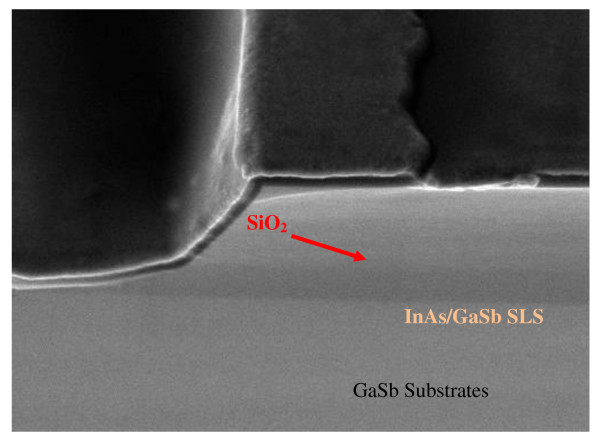
A SEM showing the sidewall passivation of the detector. The whole sidewall of the mesa was protected by the SiO2 layer.